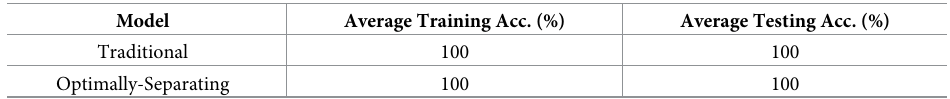
Table 2. ANN training and testing accuracies on the Iris dataset.